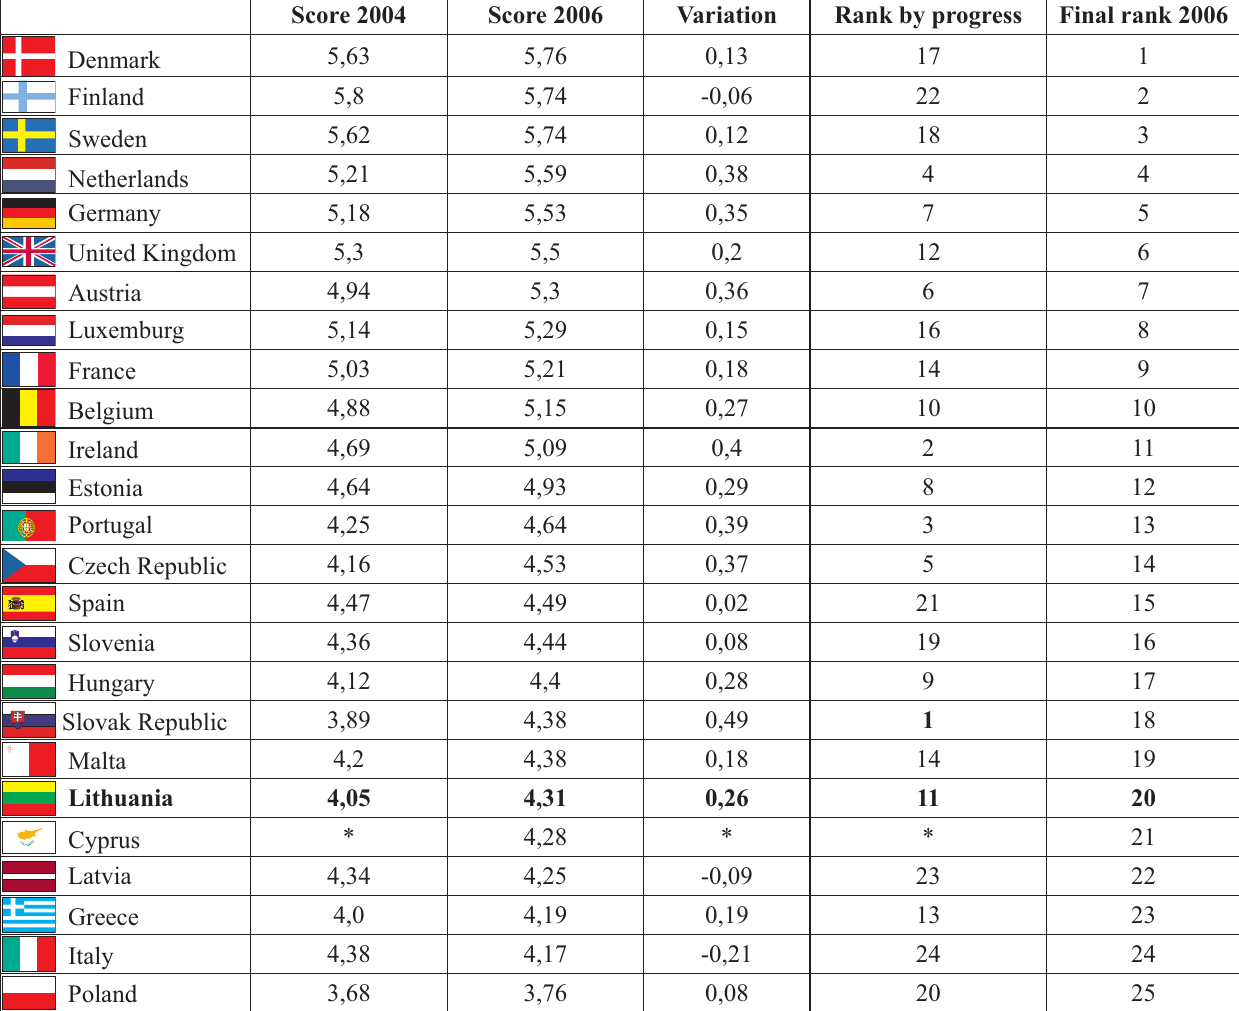
Table 3 . EU countries‘ progress